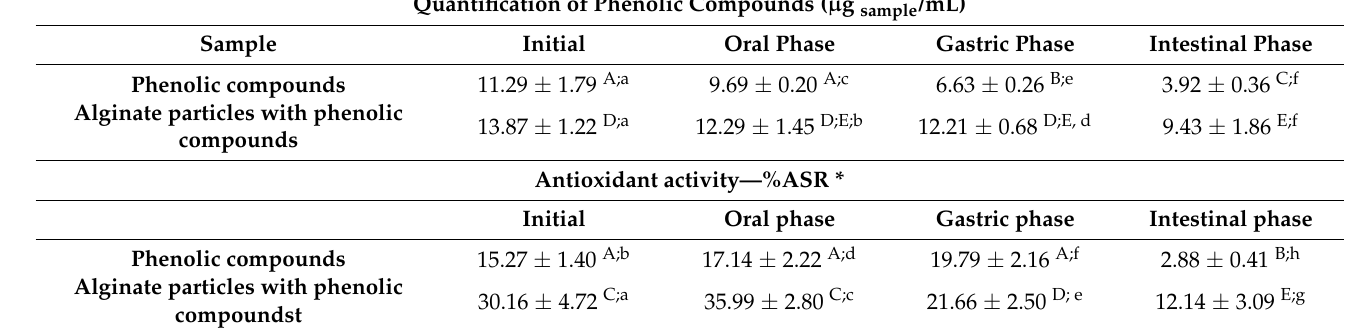
Table 4. Quantification of phenolic compounds and antioxidant activity of free phenolic compounds and alginate particles with phenolic compounds submitted to gastrointestinal